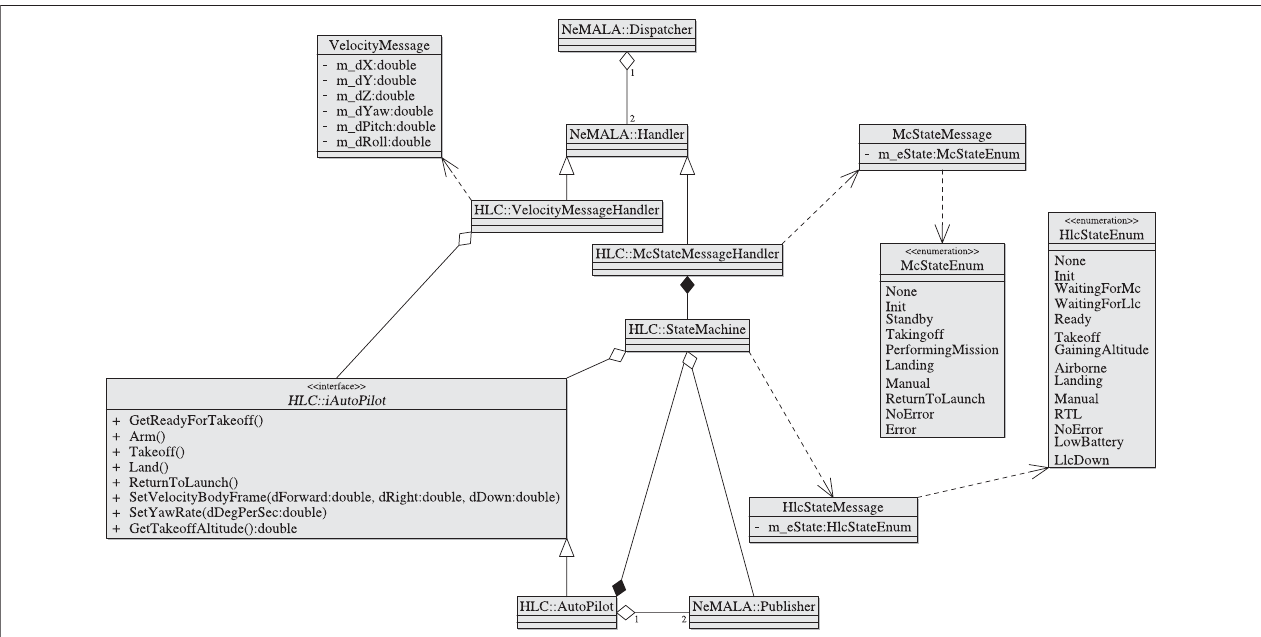
FIGURE 6 | AntAlate ’ s High Level Control class diagram. The iAutoPilot interface is a framework contract, the concrete autopilot is a Python-C++